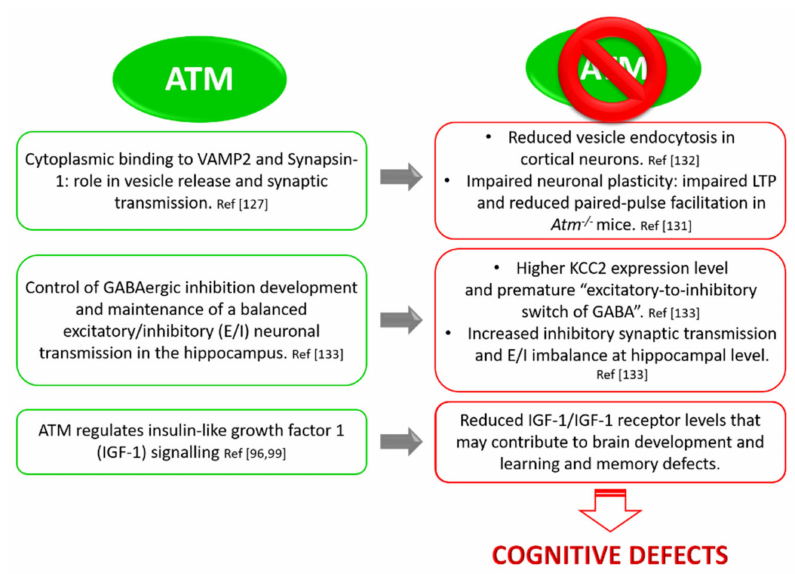
Figure 4. ATM controls synaptic function, preventing cognitive alterations. ATM is involved in synaptic vesicles release and endocytosis, GABAergic development, and maintenance of a balanced excitatory / inhibitory (E / I) neuronal transmission. In ATM deficiency conditions, neurons display impaired synaptic plasticity (LTP), defect in the maturation of inhibition, and E / I imbalance. These defects might underlie the neurological symptoms of